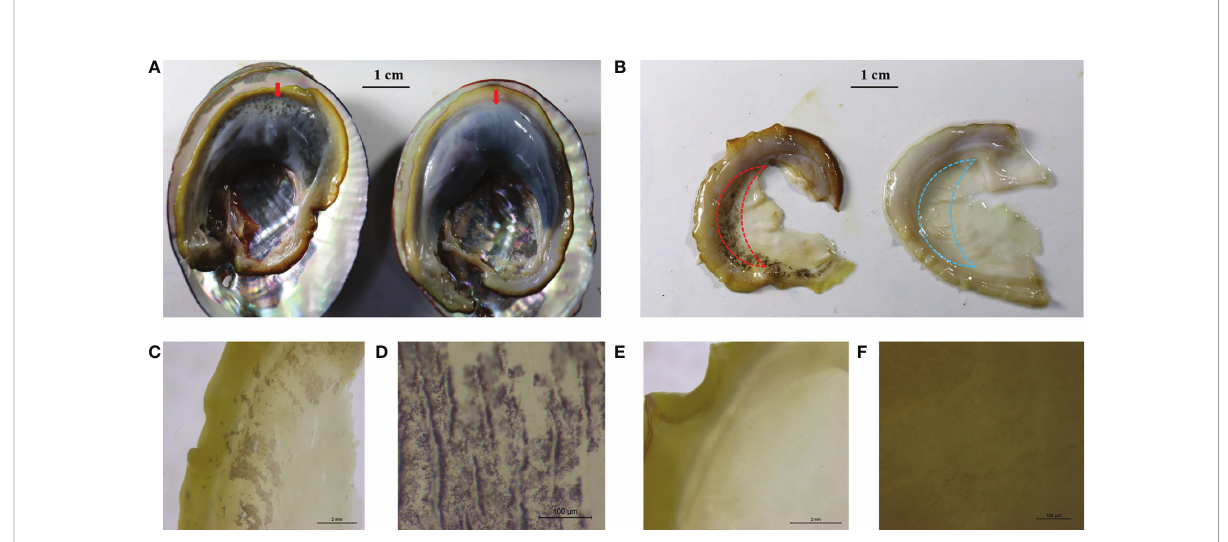
FIGURE 1 Representative mantle marking morphs. (A) An individual with black mantle markings (left, the red arrow) and an individual without black mantle markings (right, the red arrow) recorded with a digital camera, scale 1 cm. (B) Mantle with black markings (left) and mantle without black markings (right) recorded with a digital camera, scale 1 cm. Red and blue dashed lines indicate the sampling locations of RNA-seq. (C) Black mantle markings under the microscope, scale 2 mm. (D) Black mantle markings under the microscope, scale 100 m m. (E) Mantle without black markings under the microscope, scale 2 mm. (F) Mantle without black markings, scale 100 m